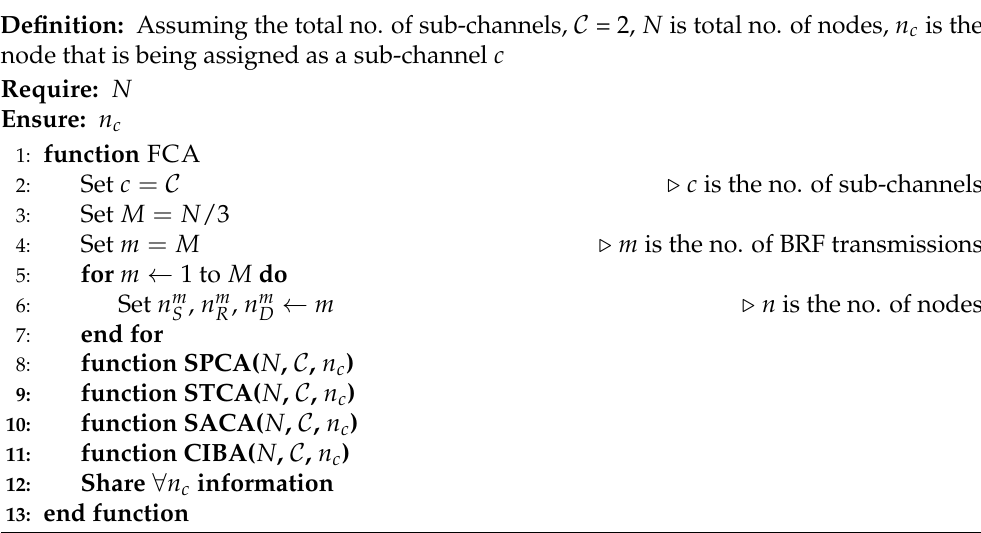
Algorithm 1 Channel Allocation Algorithm